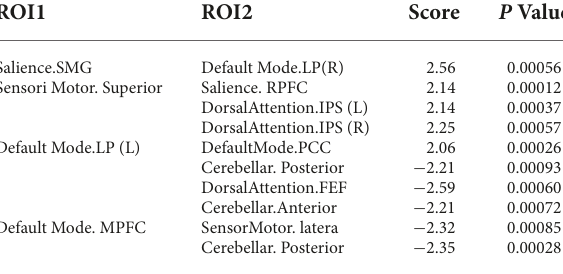
TABLE 3 Functional connections regions based on partial correlation.